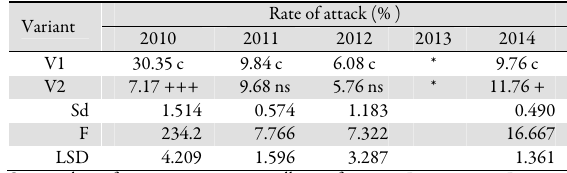
Table 3. R. cerasi attack study during 2010-2014 Beginning of flight (day.month) Year